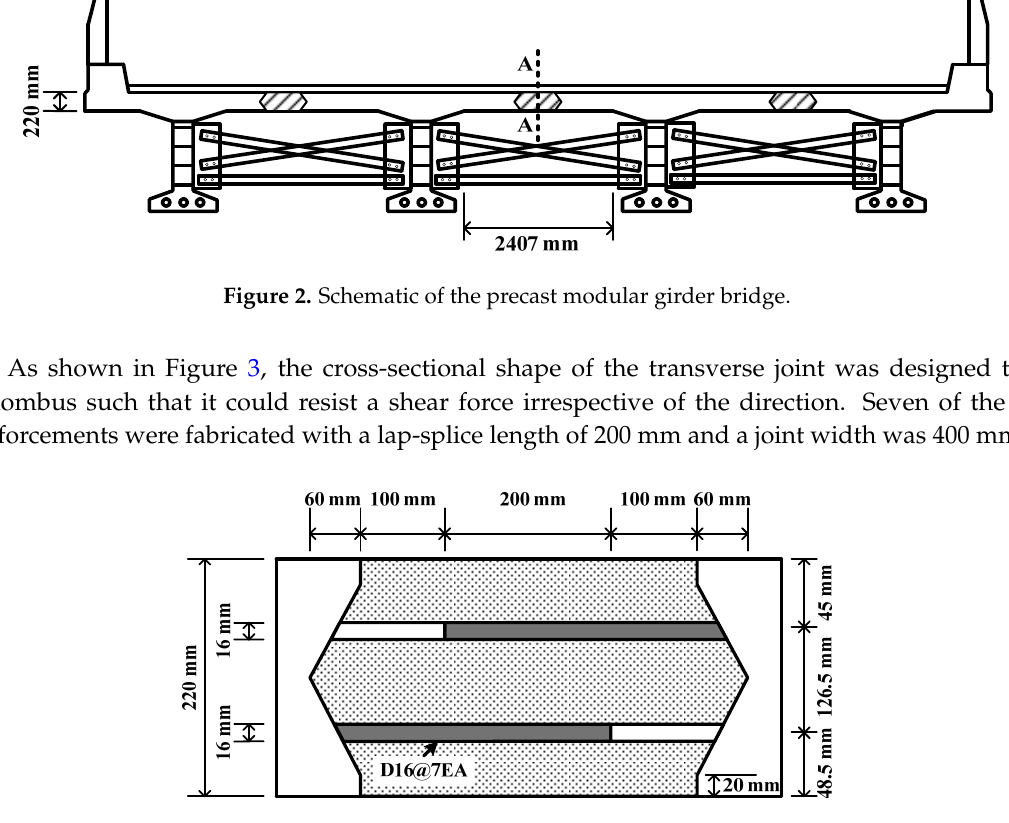
Figure 3. Detailed specification of the joint cross section.